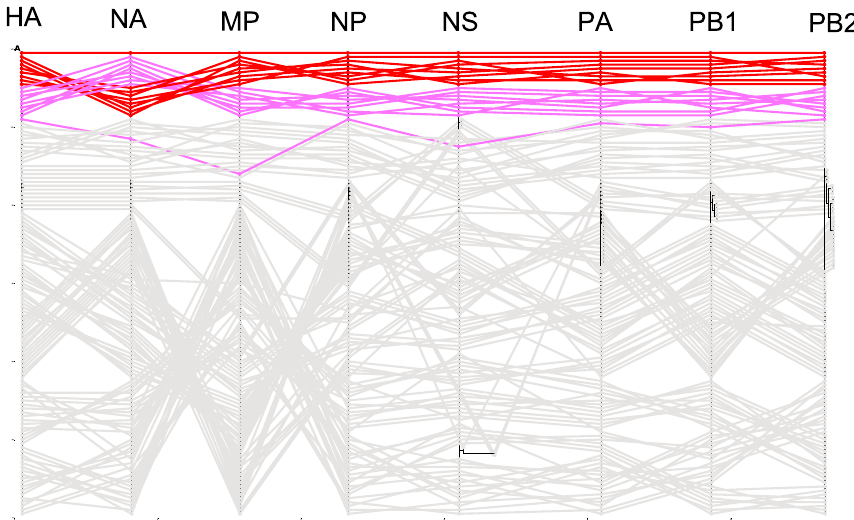
Figure 3. Phylogenetic incongruence analyses. Maximum likelihood trees for the H and N gene segments and internal gene segments from equivalent strains were connected across the trees. Tips and connecting lines are coloured according to the legend